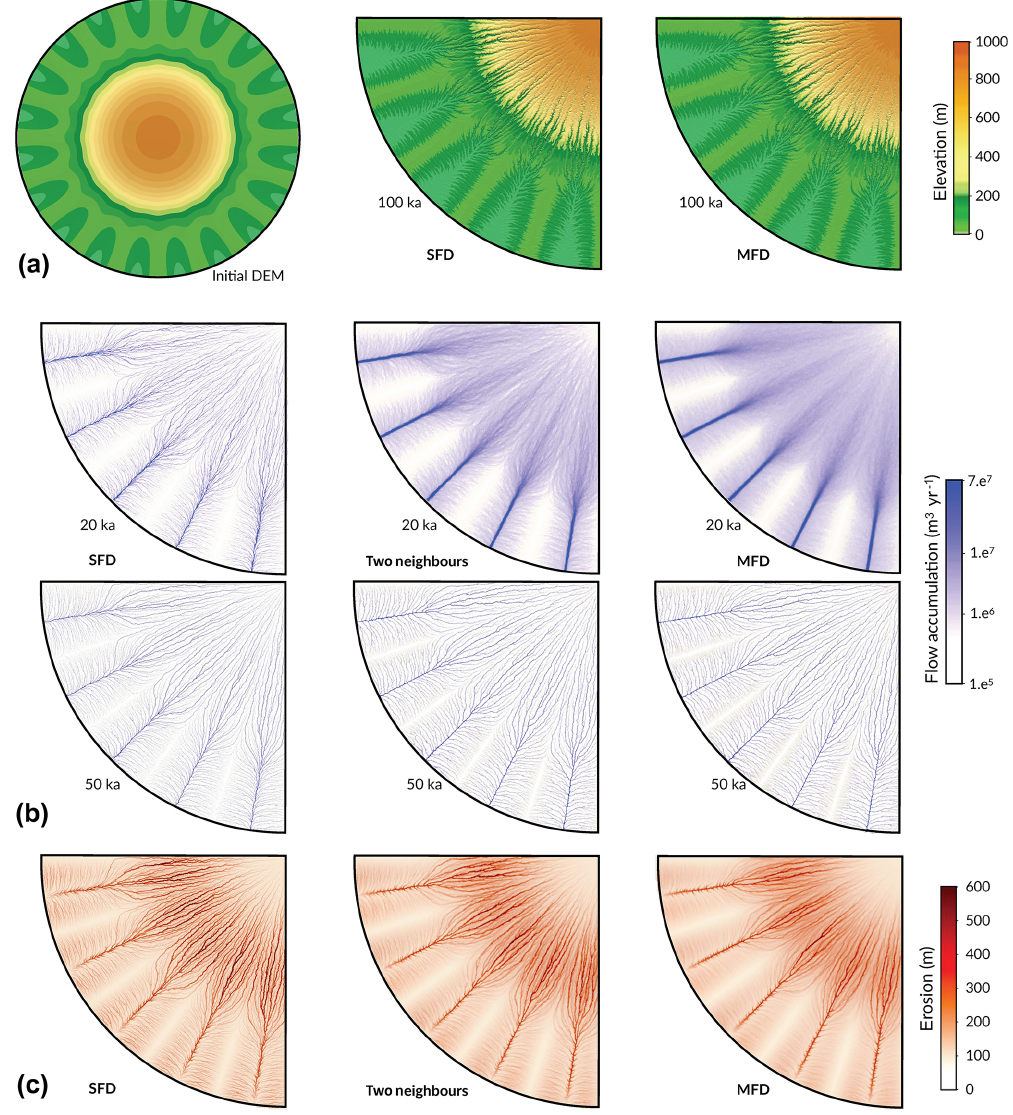
Figure 4. Effect of flow-routing algorithms on flow accumulation patterns and associated erosion. Panel (a) presents the initial radially symmetric surface defined with a central high region and a series of distal low-lying valleys. Resulting topographies of the south-west area after 100000 years of evolution under uniform precipitation for the SFD and MFD algorithms are shown on the right-hand side. Patterns of flow accumulation after 20000 and 50000 years for the SFD, two-neighbour, and MFD approaches are presented in panel (b) , and estimated landscape erosion at the end of the simulation time interval is given in panel (c)